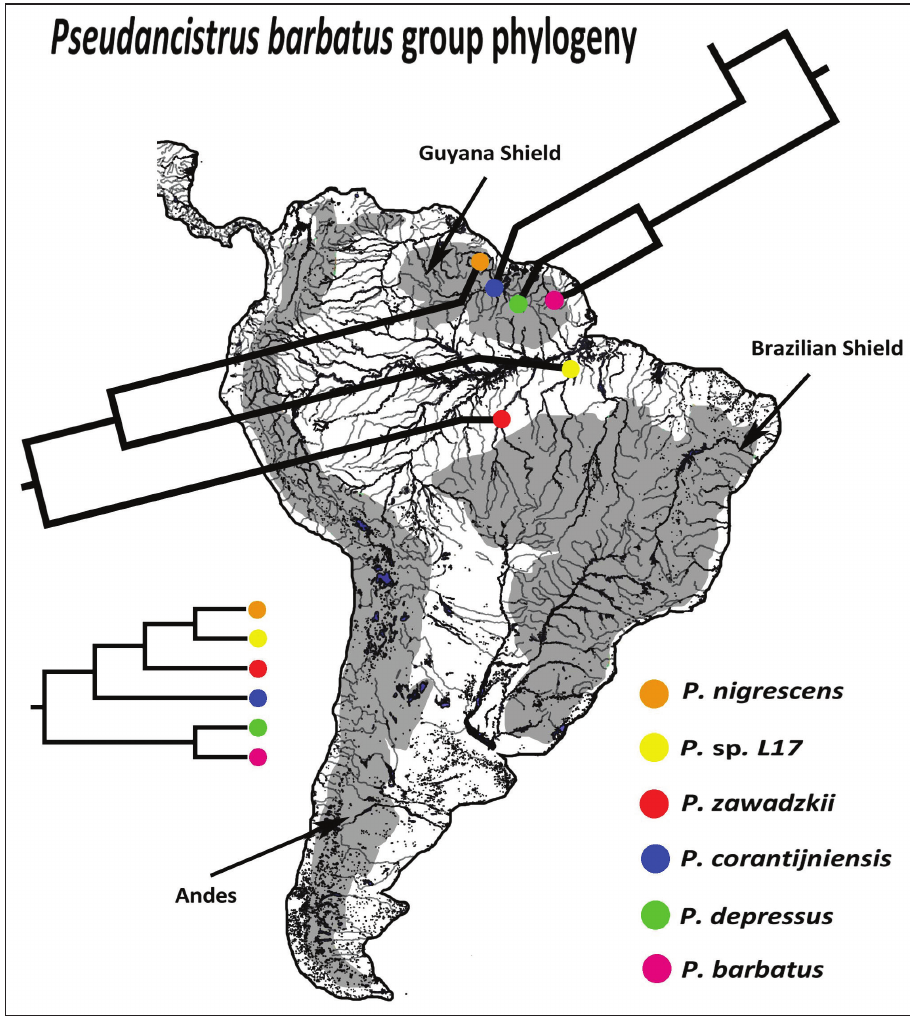
Figure 6. Distribution and phylogenetic relationships of species of the Pseudancistrus barbatus group based on F-reticulon 4 gene. Based in our first hypothesis of extand-species distribution of this group the ancestral was widespread through all Guyana Shield rivers and Amazon Brazilian Shield rivers, the spe- cies Pseudancistrus zawadzkii and Pseudancistrus sp. L17 are in the limited distribution of this group in Tapajós and Xingu rivers, drainages of Brazilian Shield into